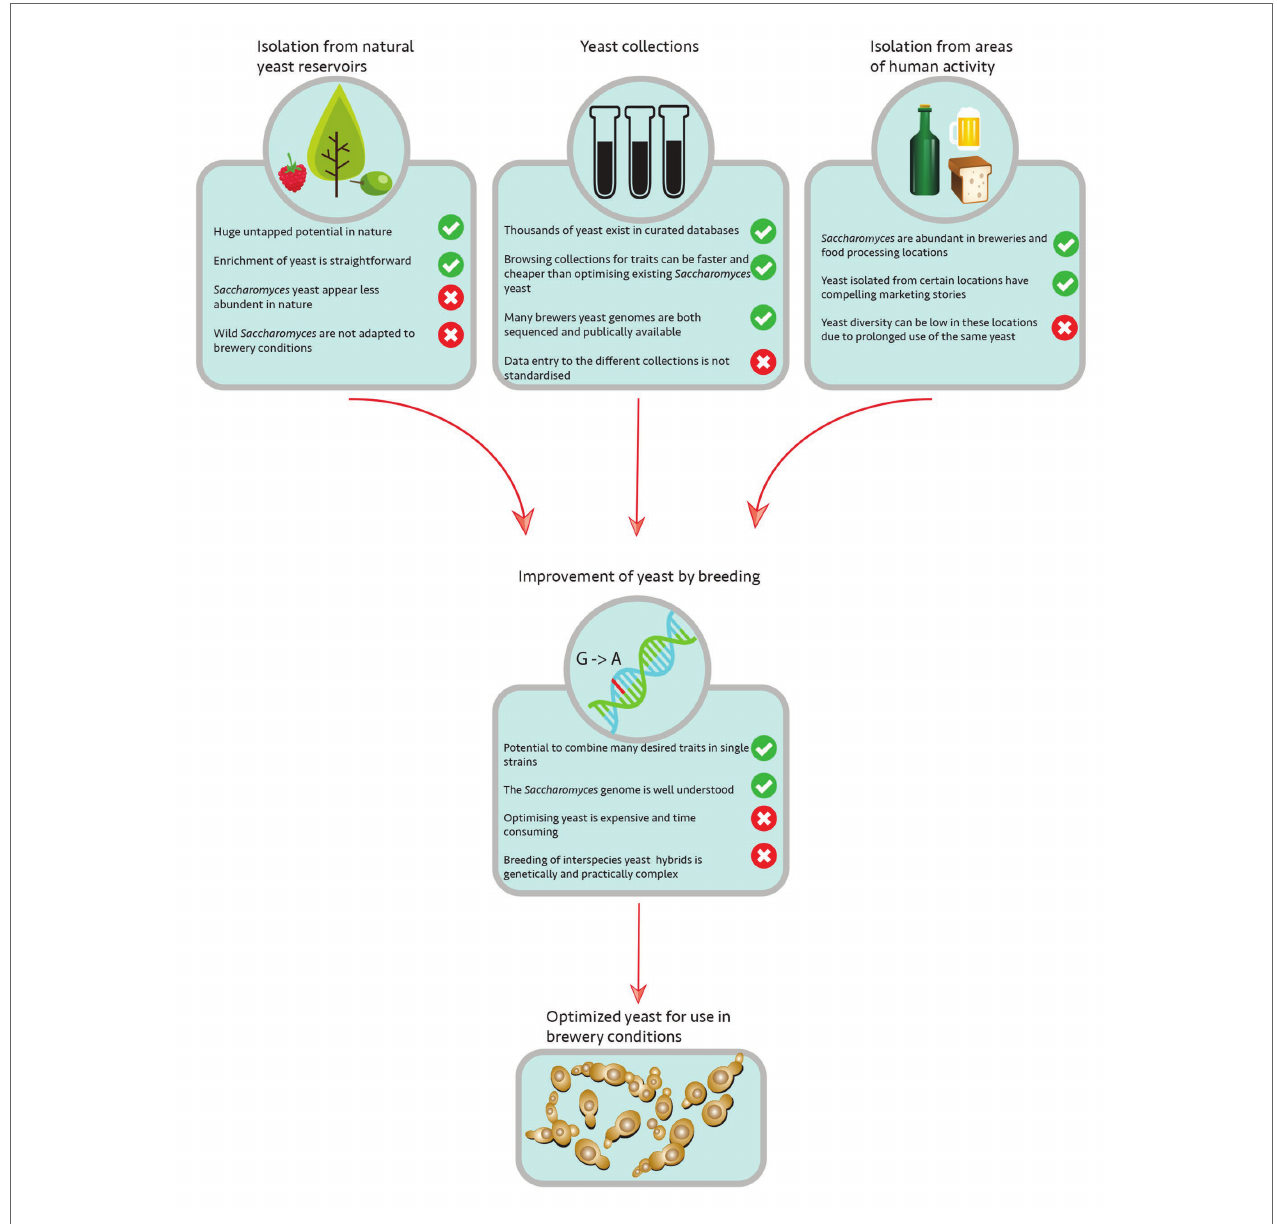
FIGURE 1 | Overview of microbial reservoirs and strategies to introduce novel Saccharomyces diversity to